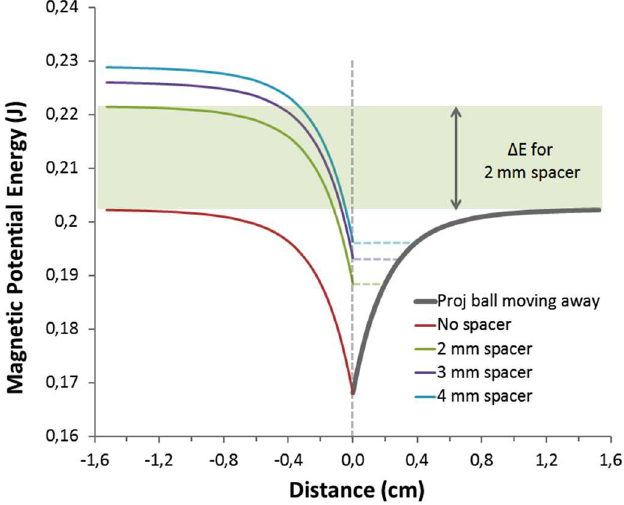
Fig. 6. Finite Element Method Magnetic (FEMM) simulation for the magnetic energy considering four different configurations of the Gauss Pendulum shooting process: no spacer, 2, 3 and 4 mm hard polymer